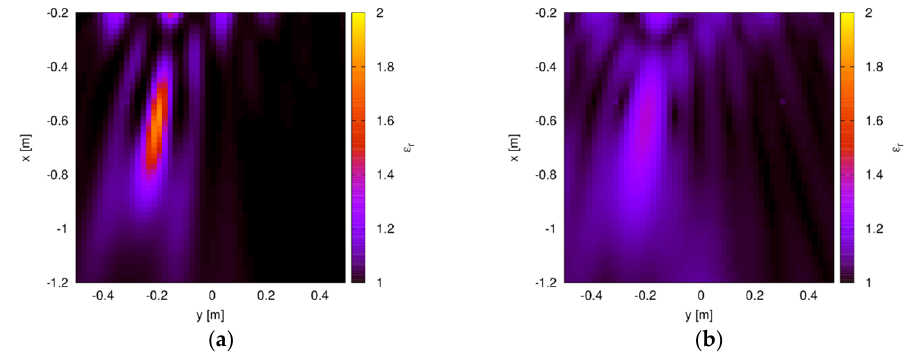
Figure 5. Reconstructed distribution of the relative dielectric permittivity inside the through-wall (TW) investigation domain. Single dielectric cylinder. ( a ) Optimal value of the norm parameter ( p opt = 1.3) and ( b ) standard Hilbert-space approach ( p = 2 ).